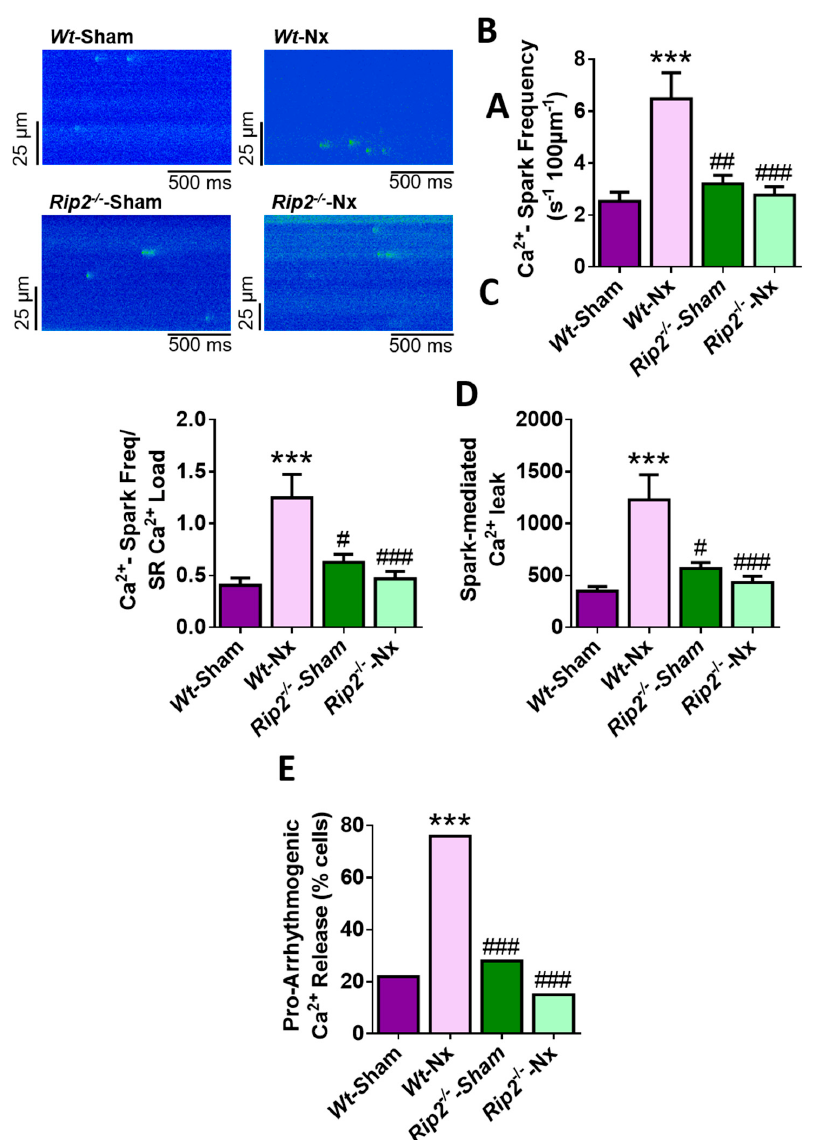
Figure 5. Deficiency of RIP2 prevents the increased frequency of Ca 2 + sparks, diastolic Ca 2 + leak and pro-arrhythmogenic Ca 2 + events provoked by 5 / 6 nephrectomy. ( A ) Representative line-scan confocal images of Ca 2 + sparks recordings obtained in a quiescent cardiomyocyte obtained from Wt -sham, Wt -Nx, Rip2 − / − -sham and Rip2 − / − -Nx. Average data of ( B ) Ca 2 + spark frequency; ( C ) normalization of Ca 2 + spark frequency by SR-Ca 2 + load; ( D ) spark-mediated Ca 2 + leak in cells isolated from Wt -sham ( n = 35 cells / four mice), Wt -Nx ( n = 38 cells / four mice), Rip2 − / − -sham ( n = 27 cells / four mice) and Rip2 − / − -Nx ( n = 47 cells/four mice) mice. ( E ) Percentage of cells with pro-arrhythmogenic Ca 2+ release in cardiomyocytes isolated all groups. Histograms show mean ± SEM. *** p < 0.001 vs. Wt -sham; # p < 0.05; ## p < 0.01; ### p < 0.001 vs. Wt -Nx.